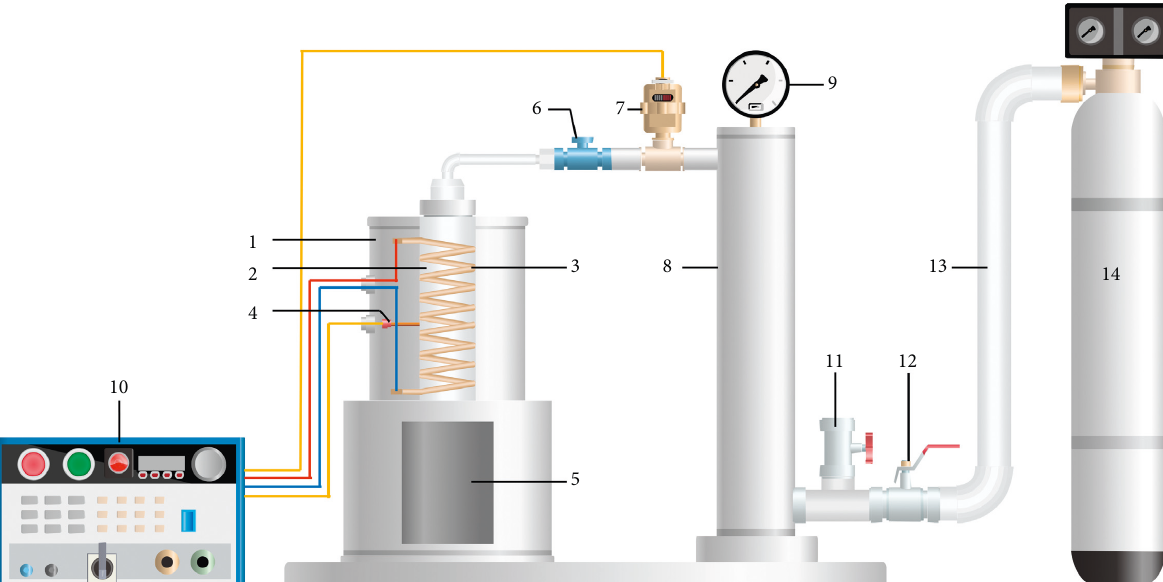
Figure 3: Godbert–Greenwald (G–G) furnace.1, Heating furnace. 2, Quartz glass tube. 3, Resistive heater. 4, Thermocouple. 5, Sight glass. 6, Dust storage chamber. 7, Solenoid valve. 8, Air storage chamber. 9, Pressure Gauge. 10, Ignition temperature. 11,Exhaust valve. 12, Inlet valve. 13, High-pressure gas pipe. 14, High-pressure air cyclinder controller. Table 2: MIT and MIE of coal dust cloud. Coal